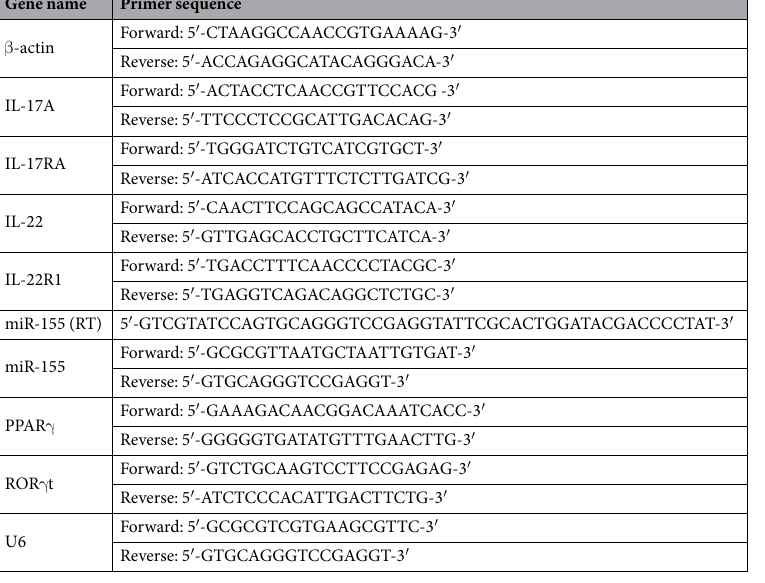
Table 1. Primer sequences in this